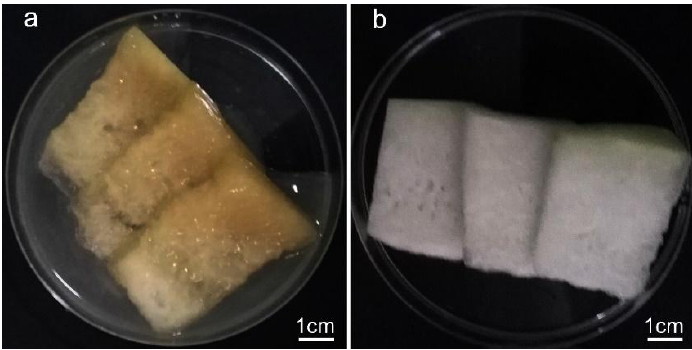
Figure 7. The storage effect on fresh-cut wax gourd after three days ( a ) without the prepared film and ( b ) with the obtained film CCSMCF2.